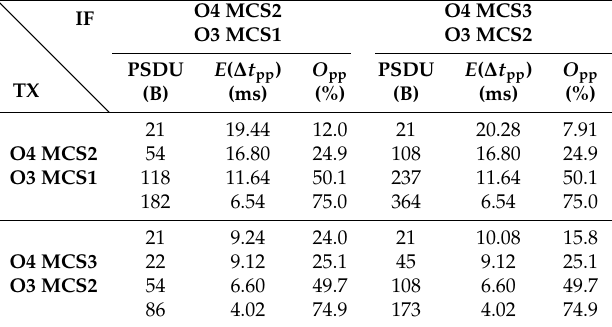
Table 3. Timing offsets and payload overlaps for given interferer PHY Service Data Unit (PSDU) sizes.